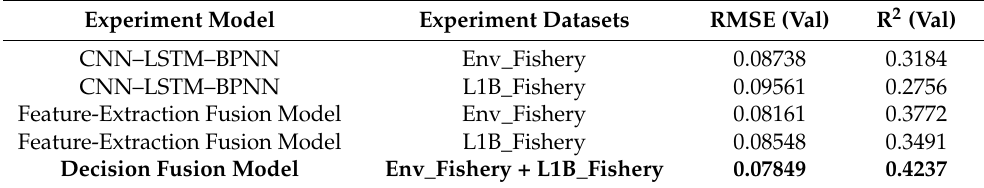
Table 6. Results of comparison between different models in the generalization experiment. Experiment